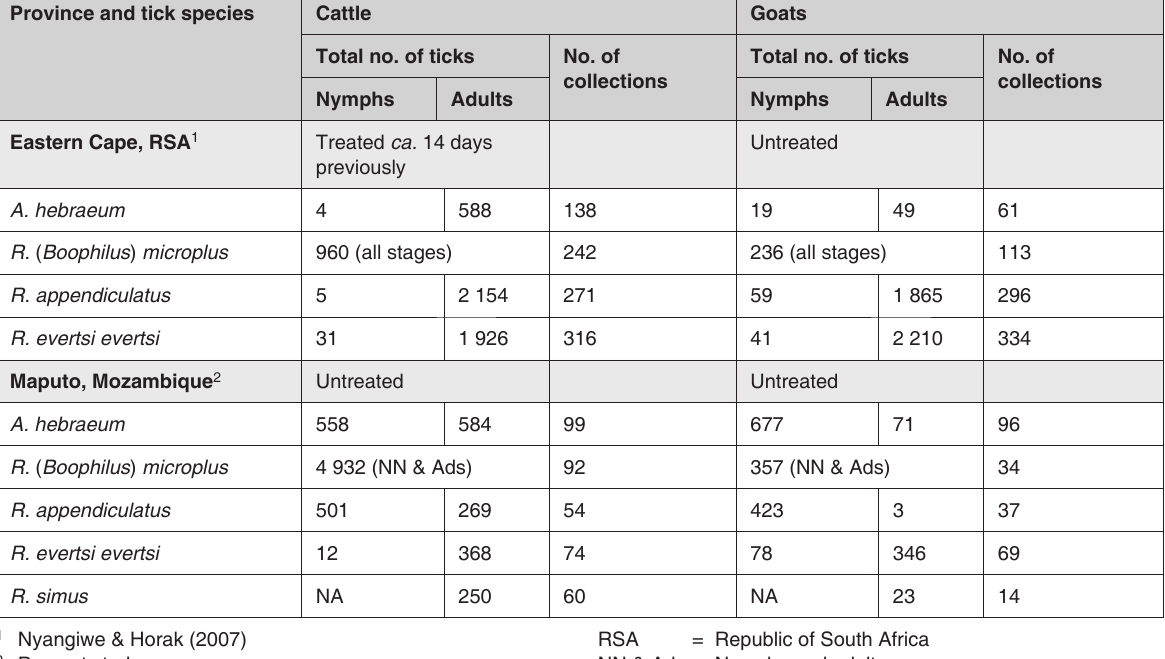
TABLE 2 Ticks collected from cattle and goats in the Eastern Cape Province, South Africa and in Maputo Province, Mozambique Province and tick species